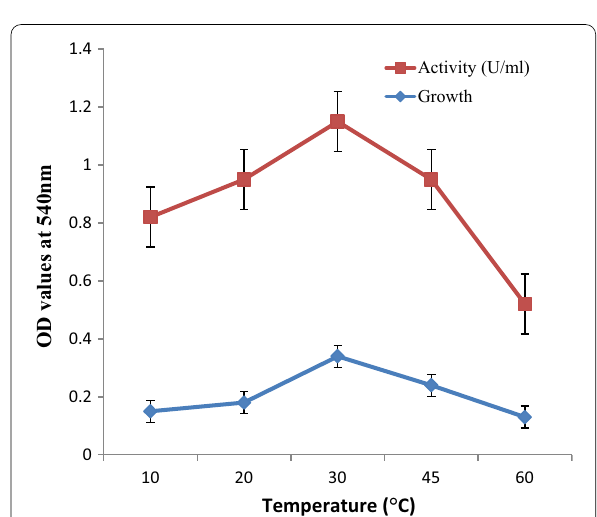
Fig. 5 Effect of temperature on the growth and linamarase activity of L. fermentum